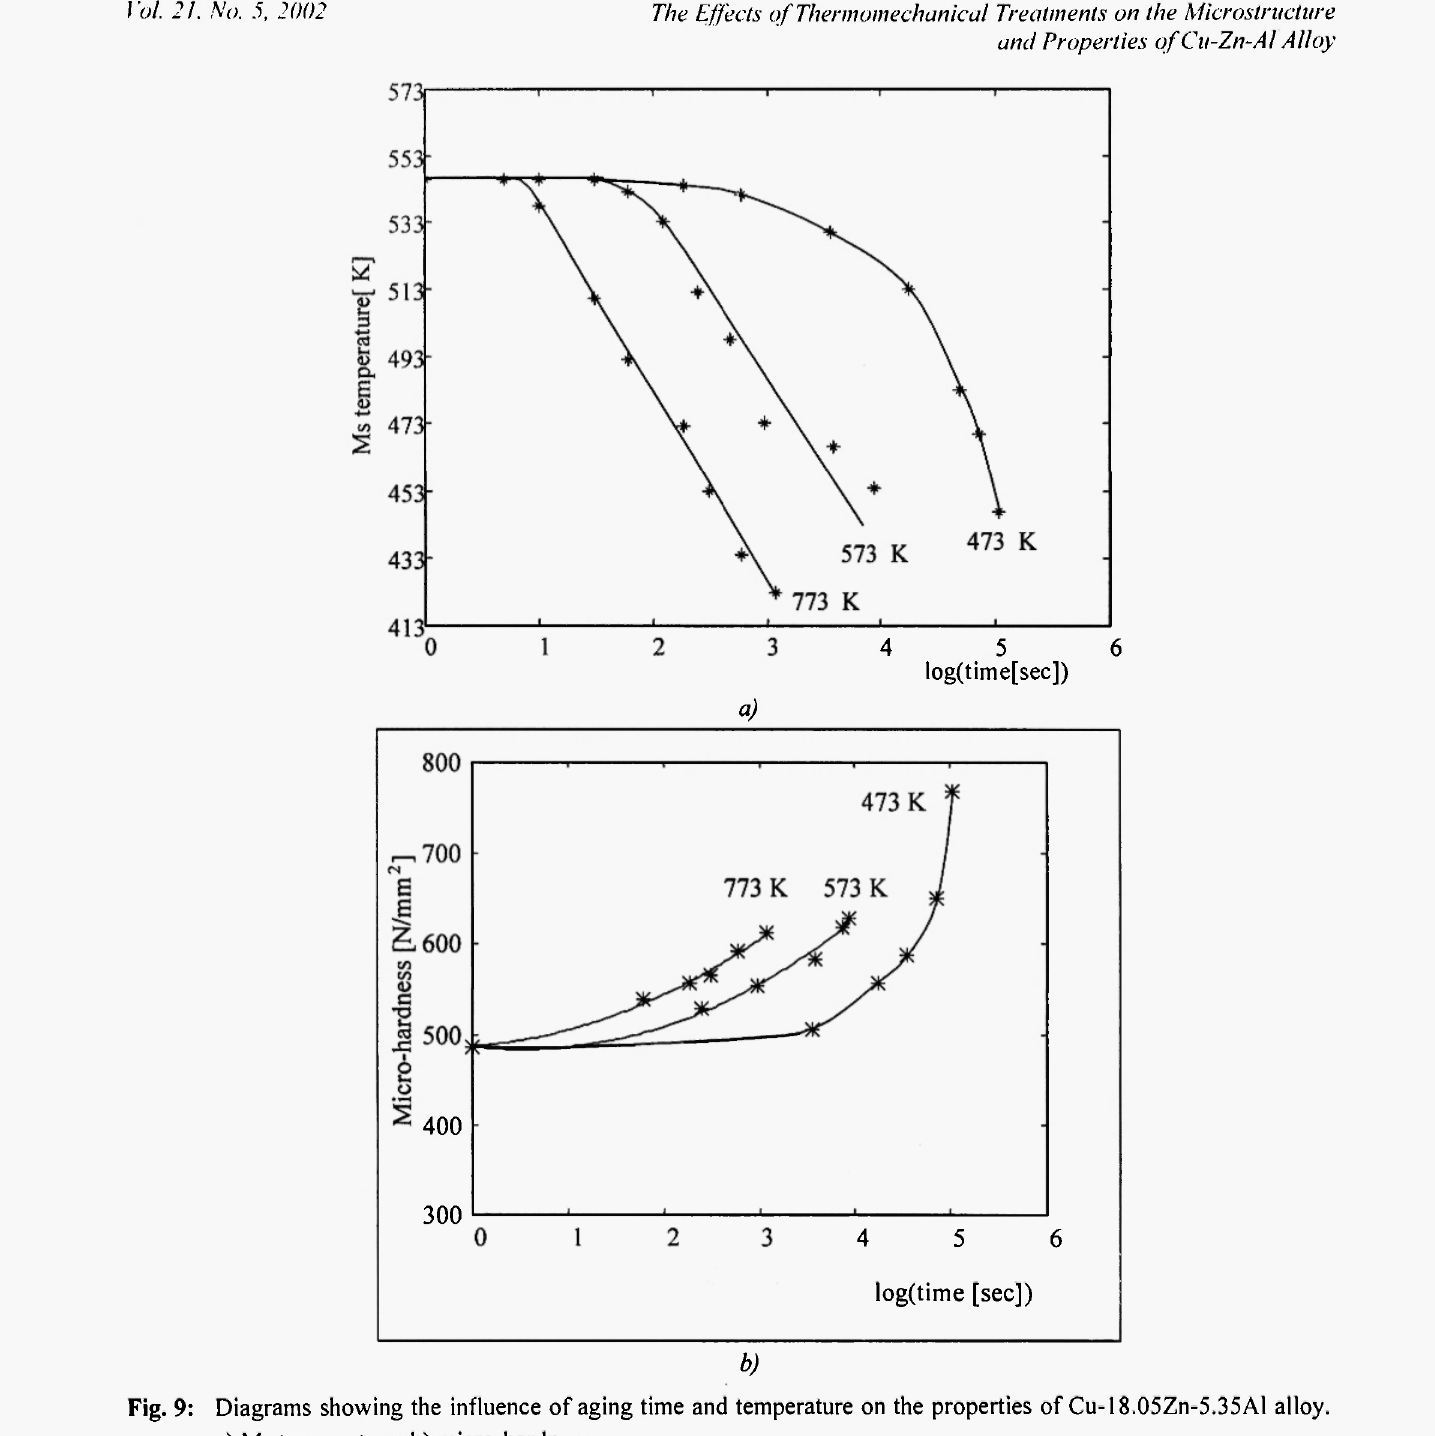
Fig. 9: Diagrams showing the influence of aging time and temperature on the properties of Cu-18.05Zn-5.35Al alloy, a) M s temperature; b)